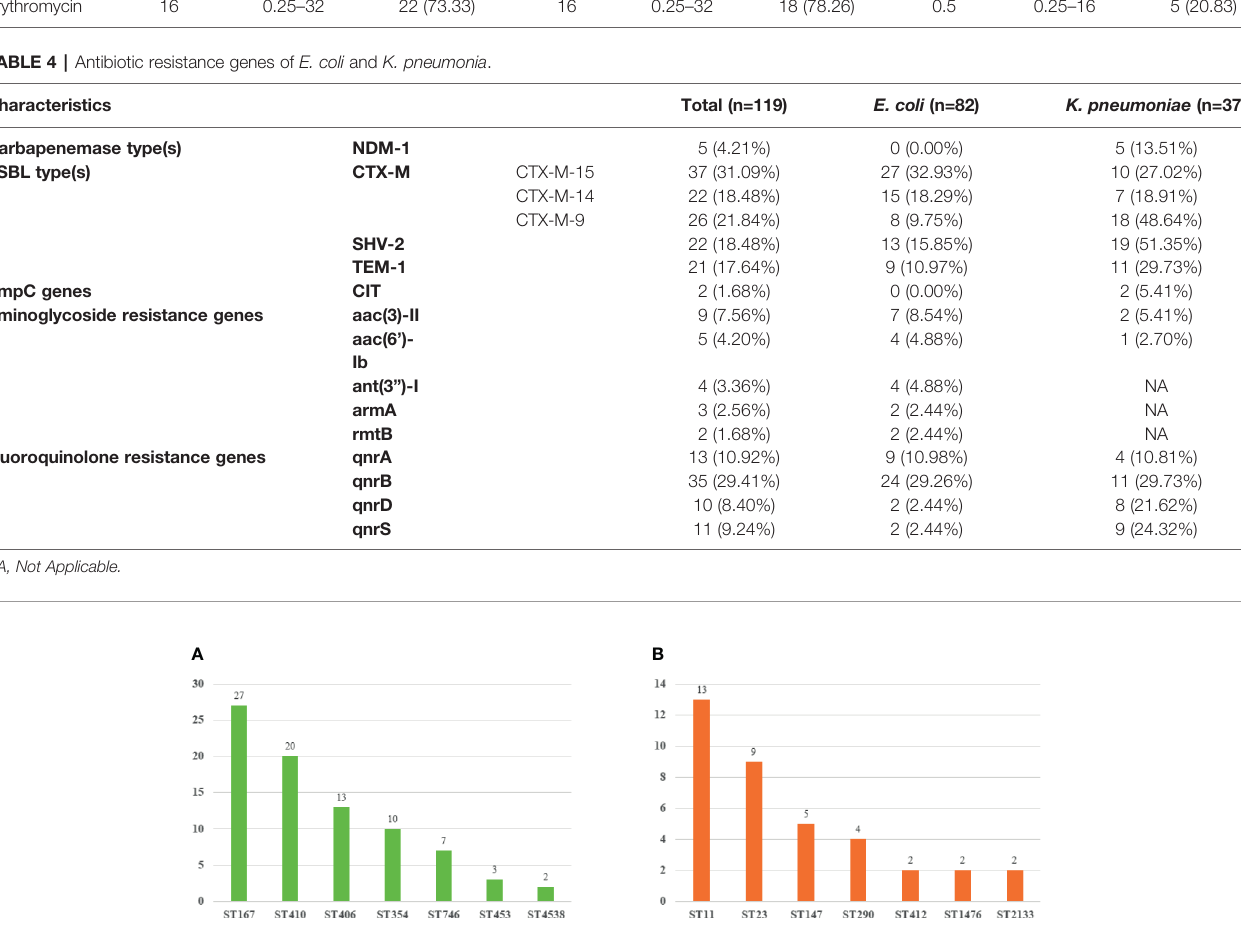
FIGURE 3 | Molecular epidemiology of E . coli and K pneumoniae. (A) MLST types of E . coli. (B) MLST types of K pneumoniae .